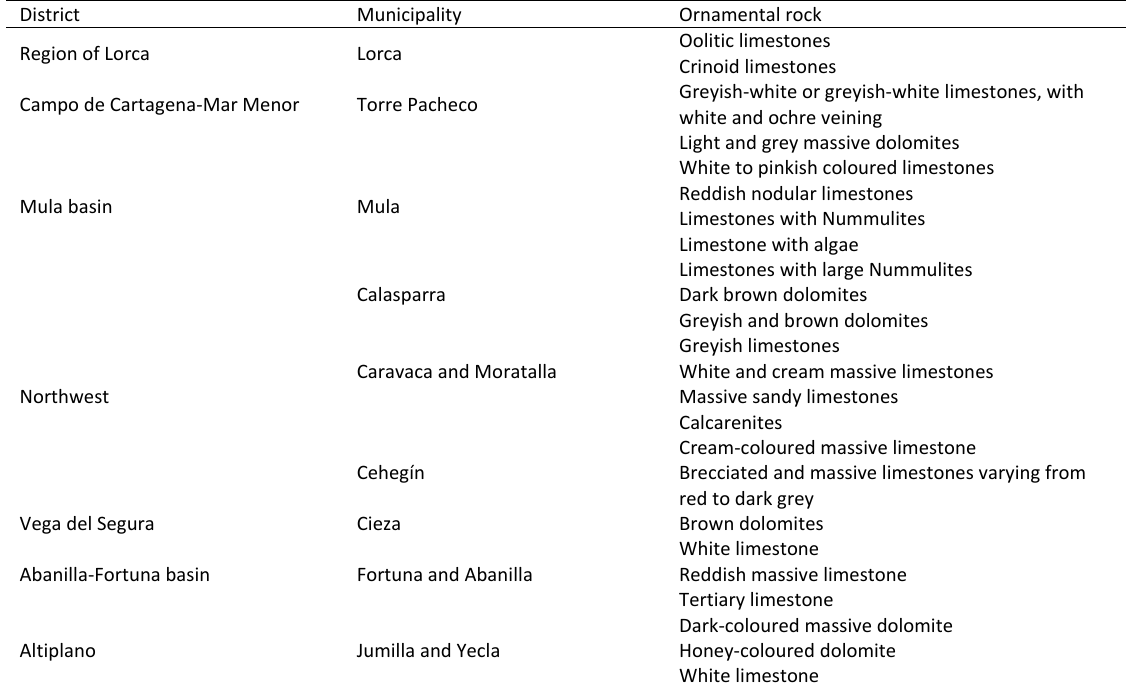
Table 2: Types of ornamental rock currently exploited in the Region of Murcia and their geographical distribution. Source: own elaboration according to data obtained from the Ministry of Business, Industry and Spokesperson of the Region of Murcia